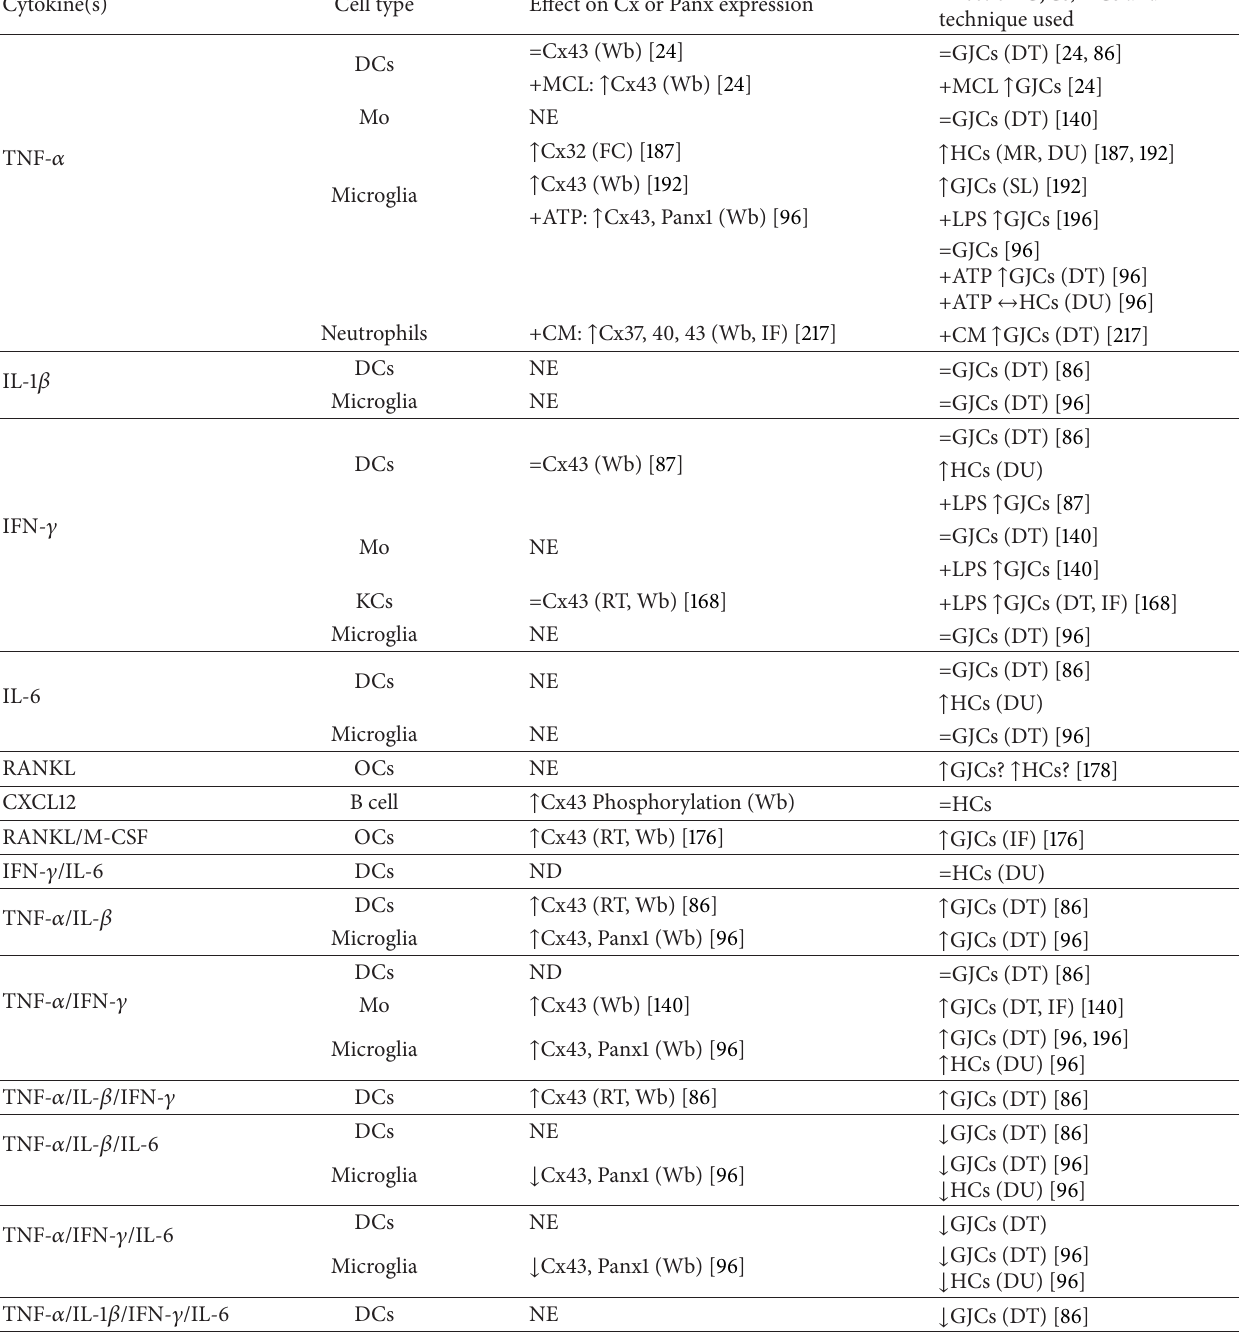
Table 1: Effect of different cytokines on GJCs and HCs in different antigen-presenting cells. Cytokine(s) Cell type Effect on Cx or Panx expression